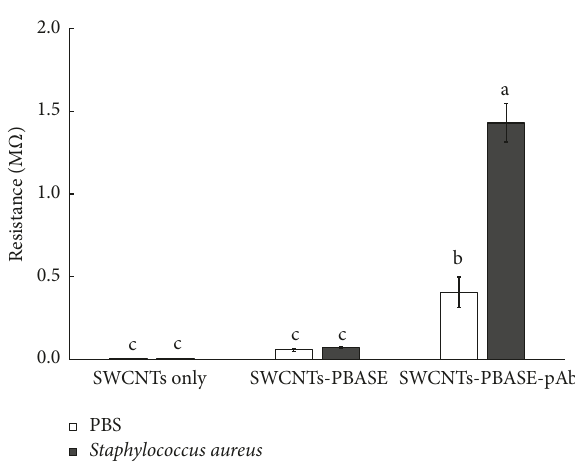
Figure 4: Resistance of SWCNT-based biosensor reacted with PBS buffer and Staphylococcus aureus culture. Error bars represent standard deviation ( 𝑛 = 3 ). Different letters (a–c) represent sig- nificant differences among the samples at 𝑃 < 0.05 . PBASE and pAbs stand for 1-pyrenebutanoic acid, succinimidyl ester, and anti- Staphylococcus aureus polyclonal antibodies,